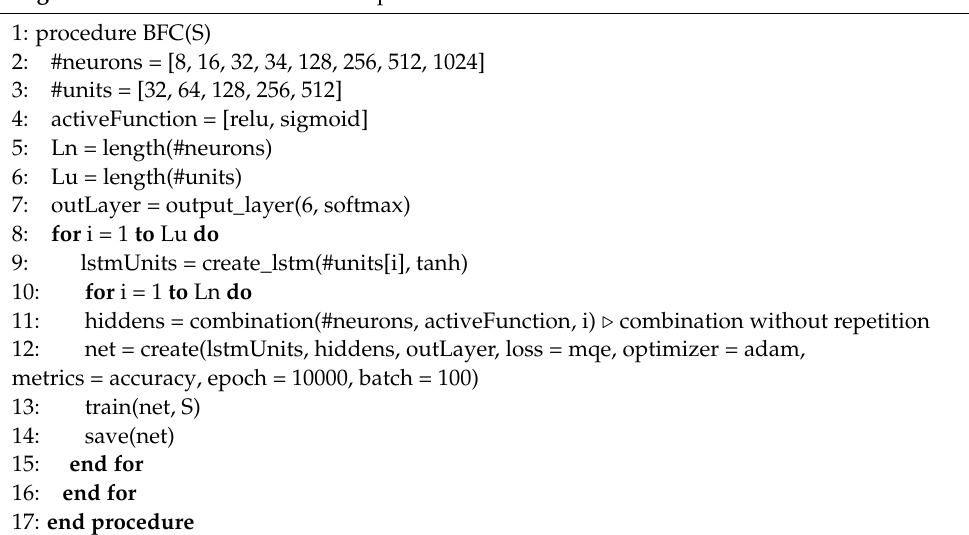
Algorithm 1 Brute force net creation